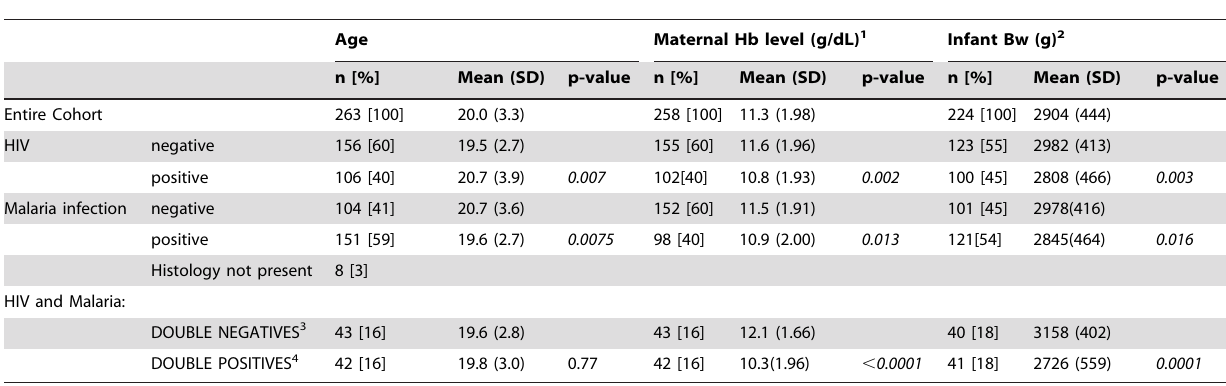
Table 2. Associations of HIV and malaria infections in the